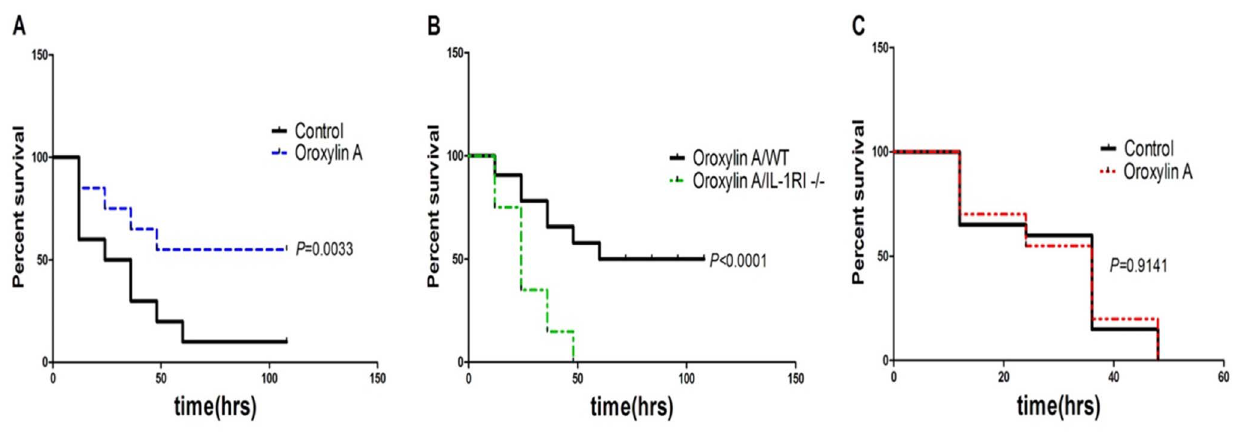
Figure 6. Oroxylin A increased probability of survival after a lethal dose of CCl 4 treatment (2.6 ml/kg body weight). (A) WT mice were respectively administered with or without oroxylin A once per day for 5 days after CCl 4 (2.6 ml/kg body weight) treatment ( P =0.0033). (B) After a lethal dose of CCl 4 (2.6 ml/kg body weight) treatment, the probalility of survival in IL-1RI 2 / 2 mice significantly decreased compared to the WT mice ( P , 0.0001). (C) Oroxylin A administration could not improve survival of IL-1RI 2 / 2 mice after a lethal dose of CCl 4 (2.6 ml/kg body weight) performace, which indicated that oraoxylin A protects against CCl 4 -induced acute liver failure directly through regulating IL-1Ra/IL-1RI pathway ( P =0.9141, non-significant). Survivals were scored twice per day, and the results were analyzed using the log-rank test and expressed as the Kaplan- Meier survival curves (n=20).